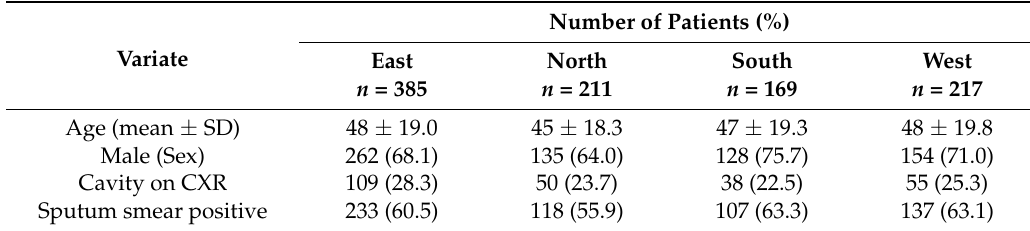
Number of Patients